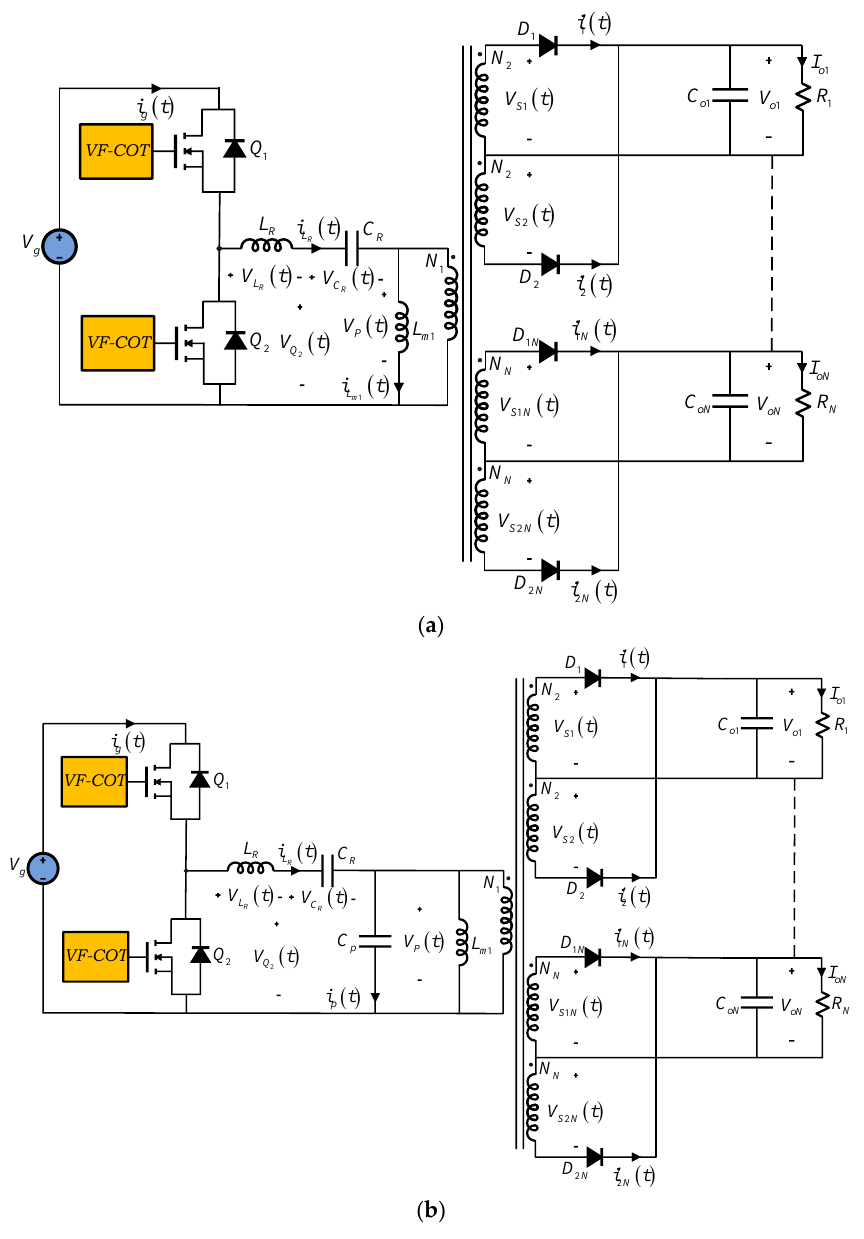
Figure 6. Three-element Multiple-Output Isolated Resonant DC – DC Converters: LLC and LCC. ( a ) LLC Resonant DC – DC Converter. ( b ) LCC Resonant DC – DC Converter.